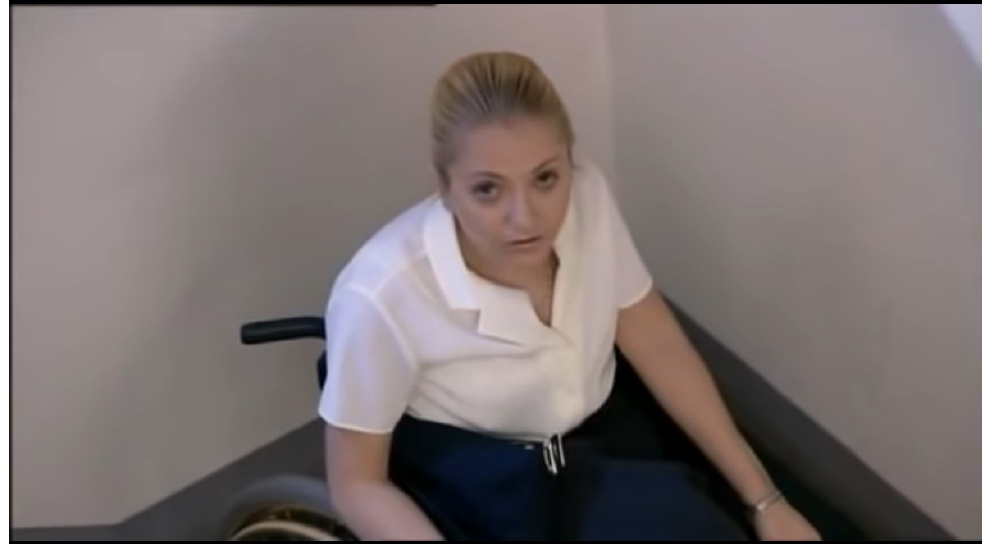
Figure 1. Brenda looks into the camera insecurely after being left alone in the middle of a staircase during a fire drill. Reproduced under the permission of fair dealing; copyright BBC 2002.